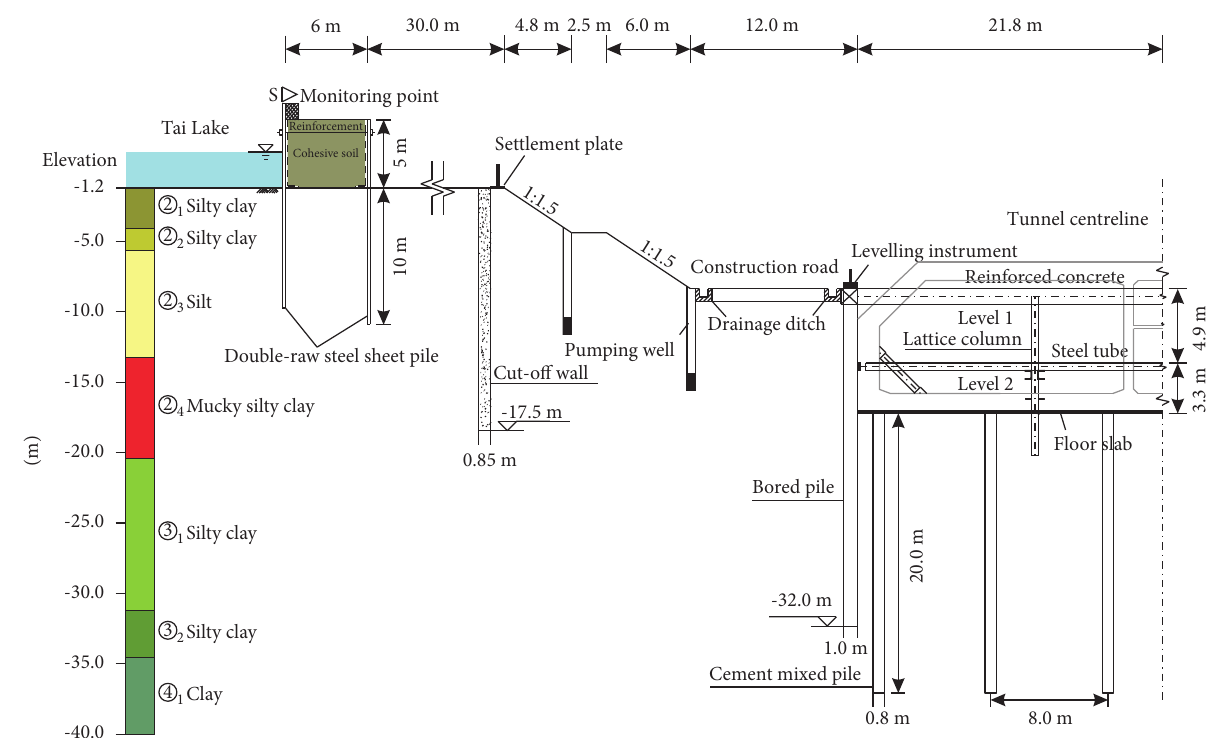
Figure 5: Typical cross section on the north side of Zone